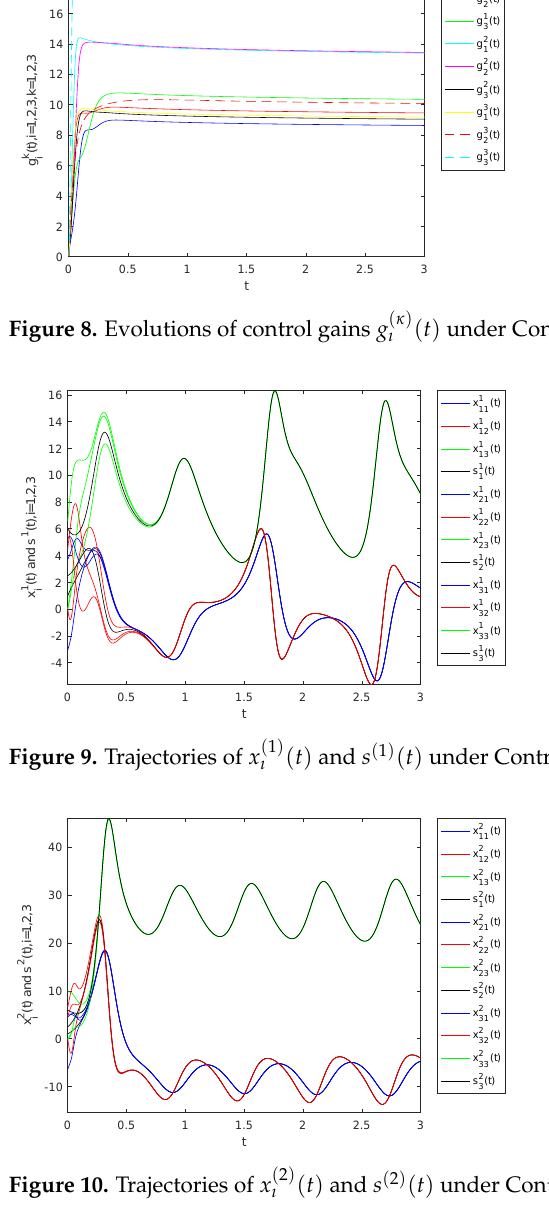
Figure 10. Trajectories of x